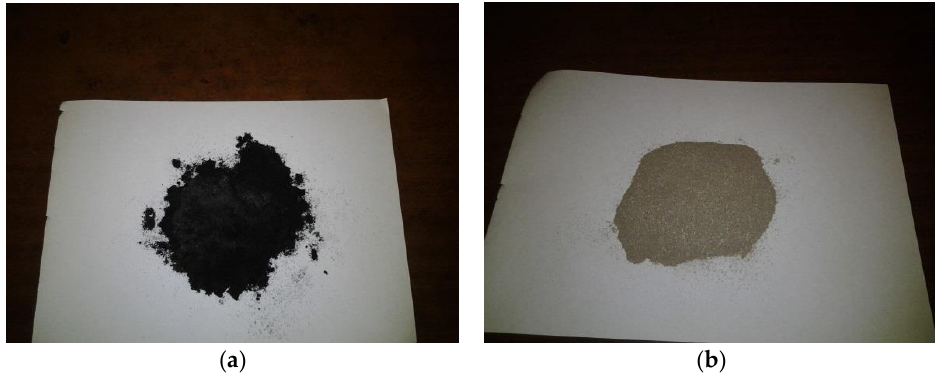
Figure 2. Images of sugarcane bagasse: ( a ) Torrefied at 300 °C with at a residence time of 5 min; ( b ) untorrefied.